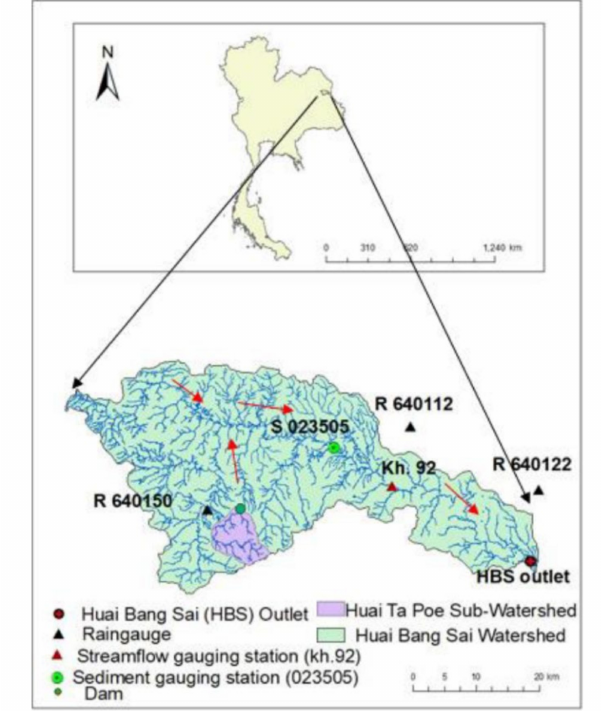
Figure 2. Location map of Huai Bang Sai (HBS) and Huai Ta Poe watersheds and rainfall, streamflow, and sediment gauging stations.